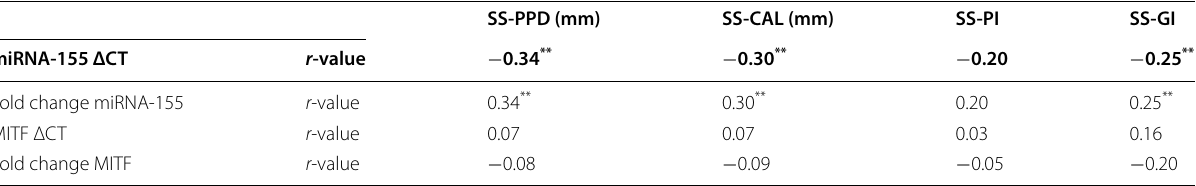
Table 5 Spearman correlation between the standardized ΔCT and fold change values of miRNA-155 and MITF gene expression with the clinical parameters